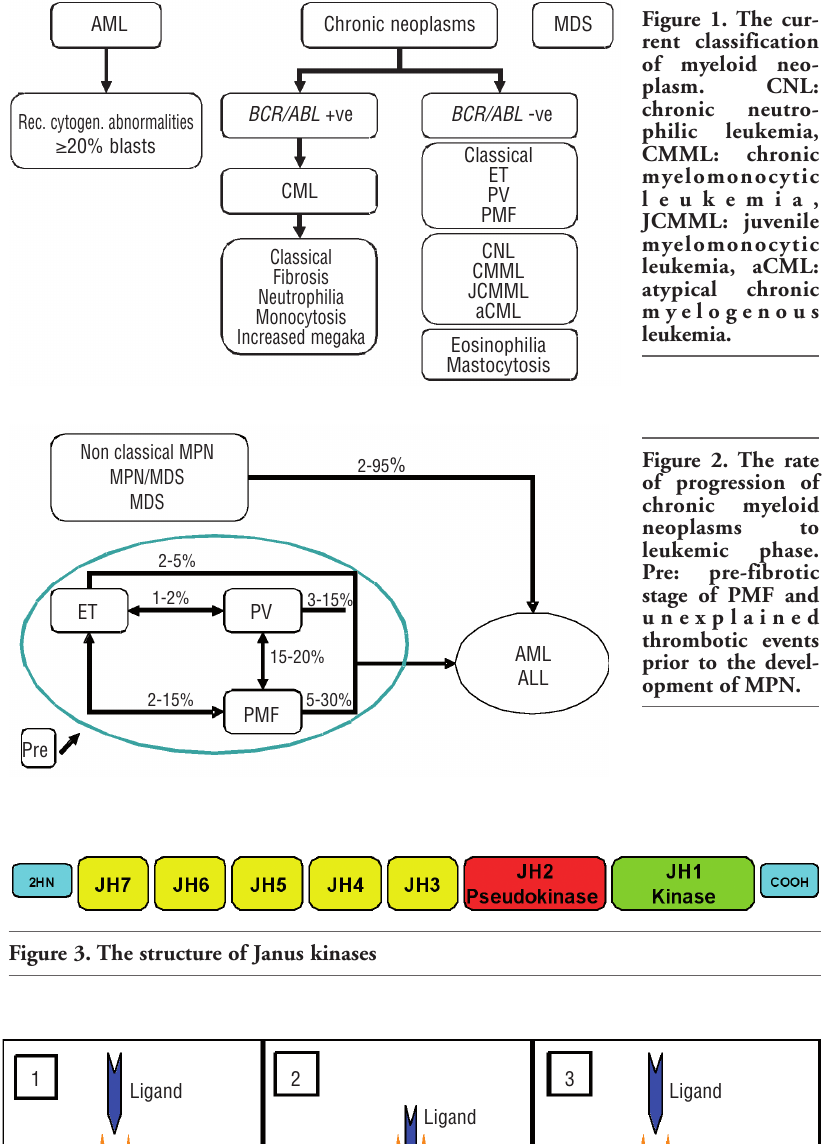
Figure 1. The cur- rent classification of myeloid neo- plasm.